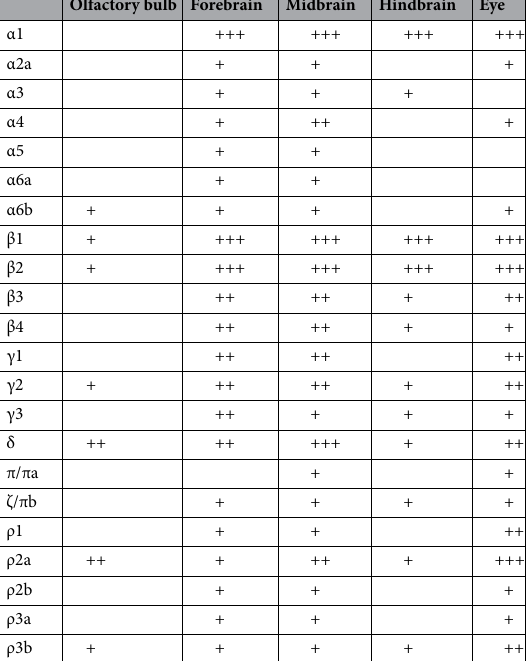
Table 1. Expression patterns of GABA A receptor subunit genes in zebrafish larvae at 5 dpf. Note that +++, ++, and + indicate the intensity of